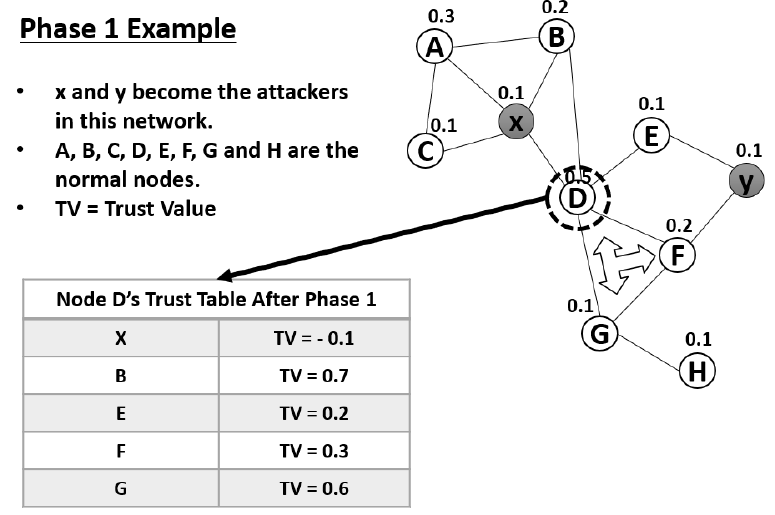
Figure 6. Demonstration of Phase